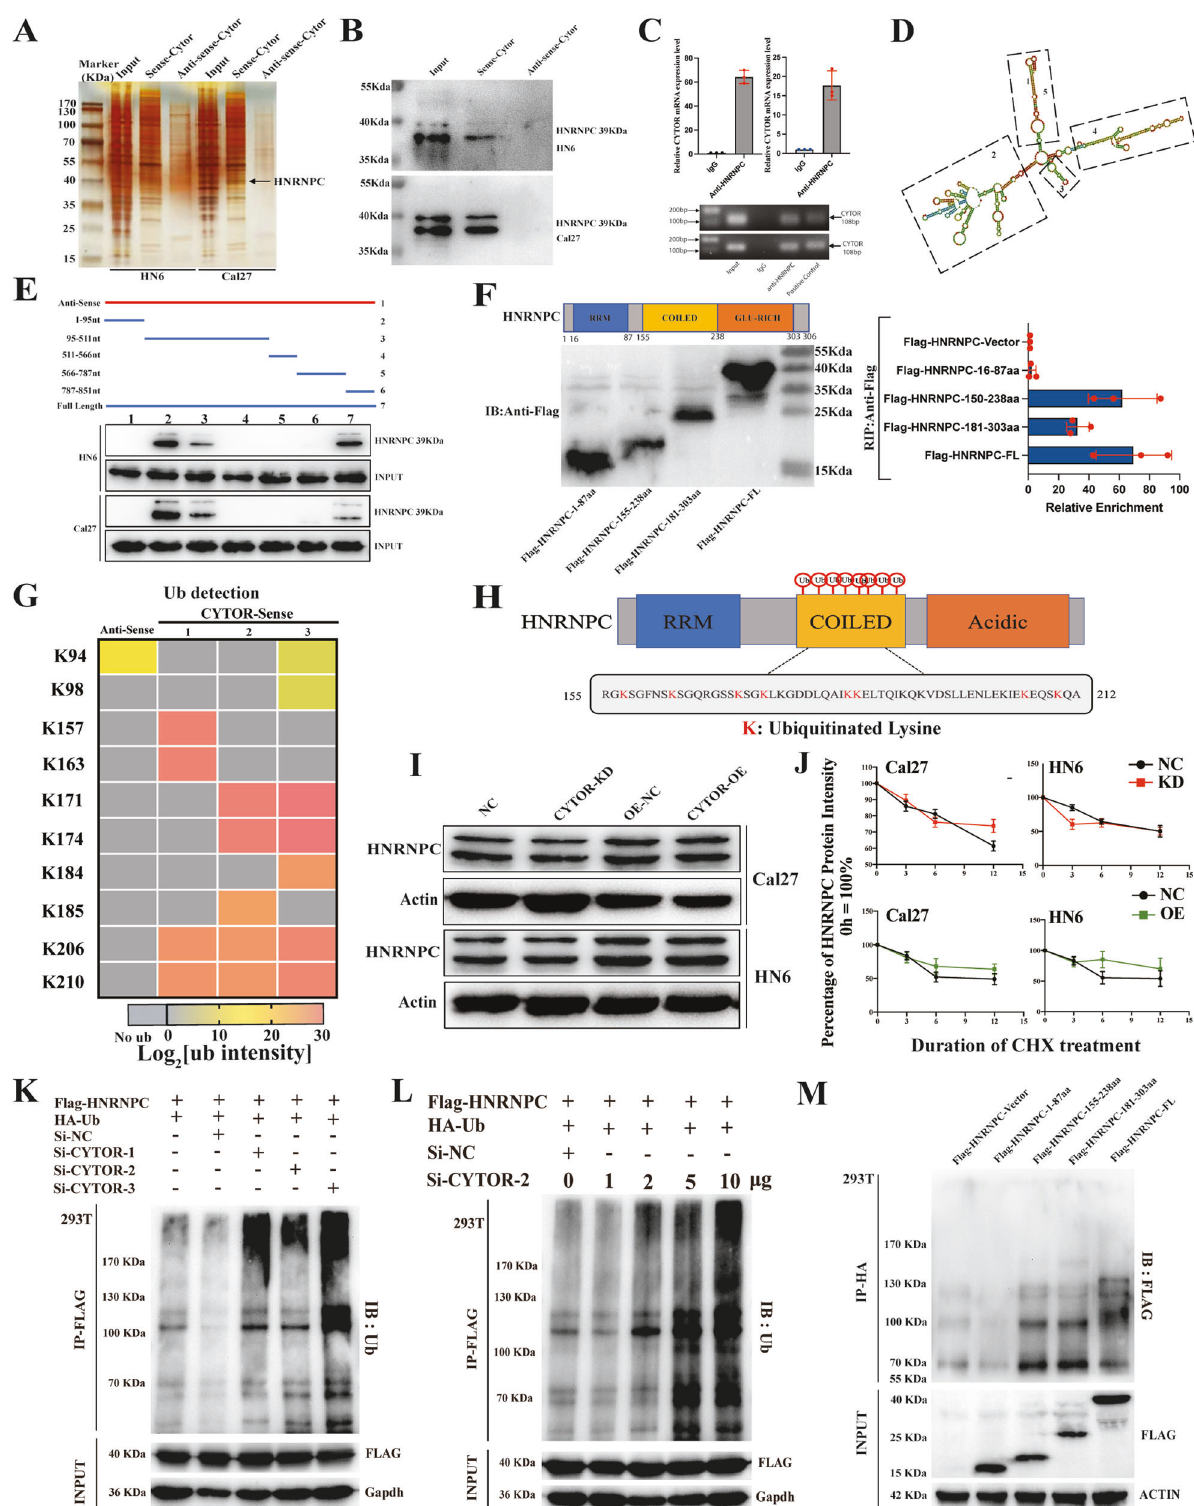
Next, we transfected the HN6 and Cal27 oral cancer cell lines with small interfering RNAs or a pcDNA plasmid to knock down or overexpress HNRNPC, respectively. Analysis by WB to detect the ZEB1 protein expression in these lines demonstrated that upregulation of HNRNPC resulted in higher ZEB1